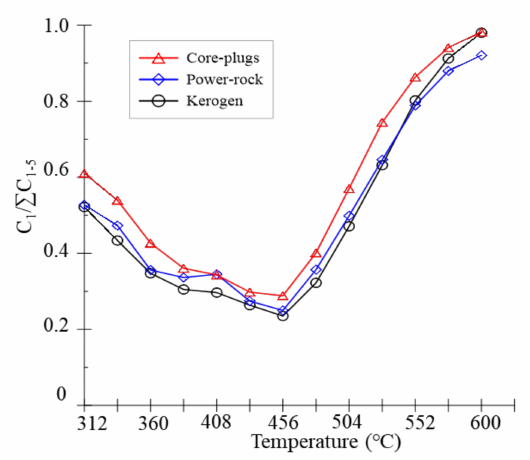
Figure 6. The dryness ratio varies with temperature.